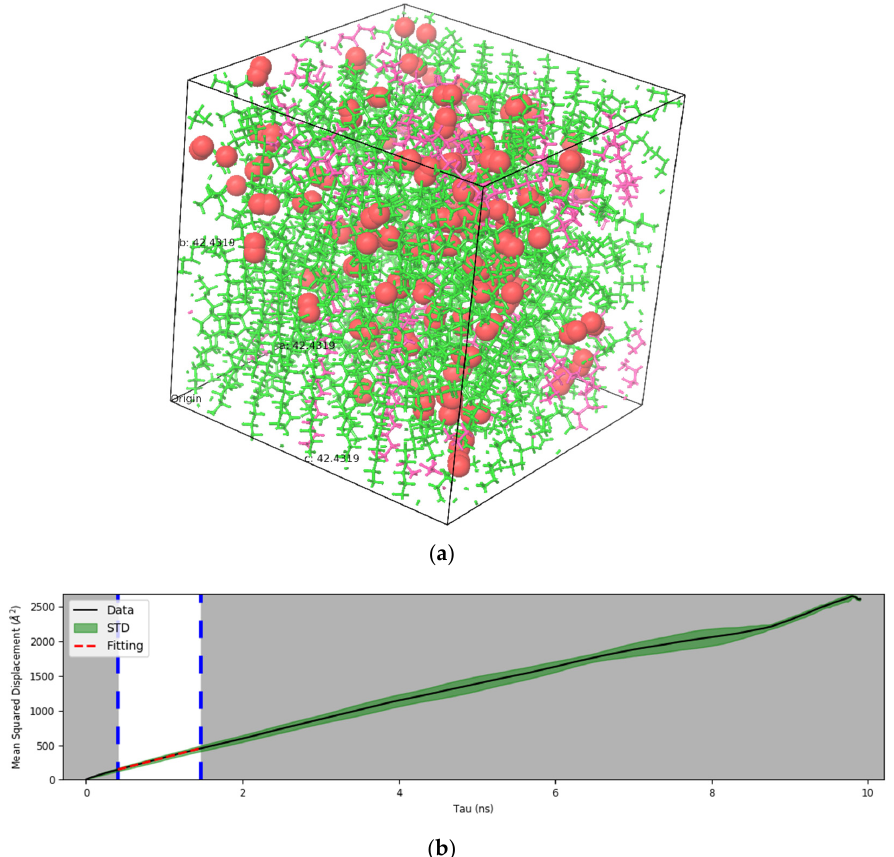
Figure 8. ( a ) PE-17.1 wt% wax and oxygen (red spheres represent oxygen atoms). ( b ) Mean square displacement curve corresponding to the PE-17.1 wt% wax and oxygen.